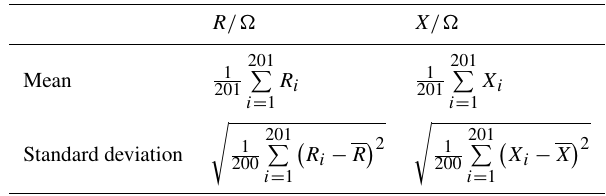
Table 4. Equations of the mean and standard deviation features for the real and imaginary parts of the impedance spectrum. The index i is the running variable of the 201 points of the impedance spectrum (Toutenburg and Heumann, 2008).